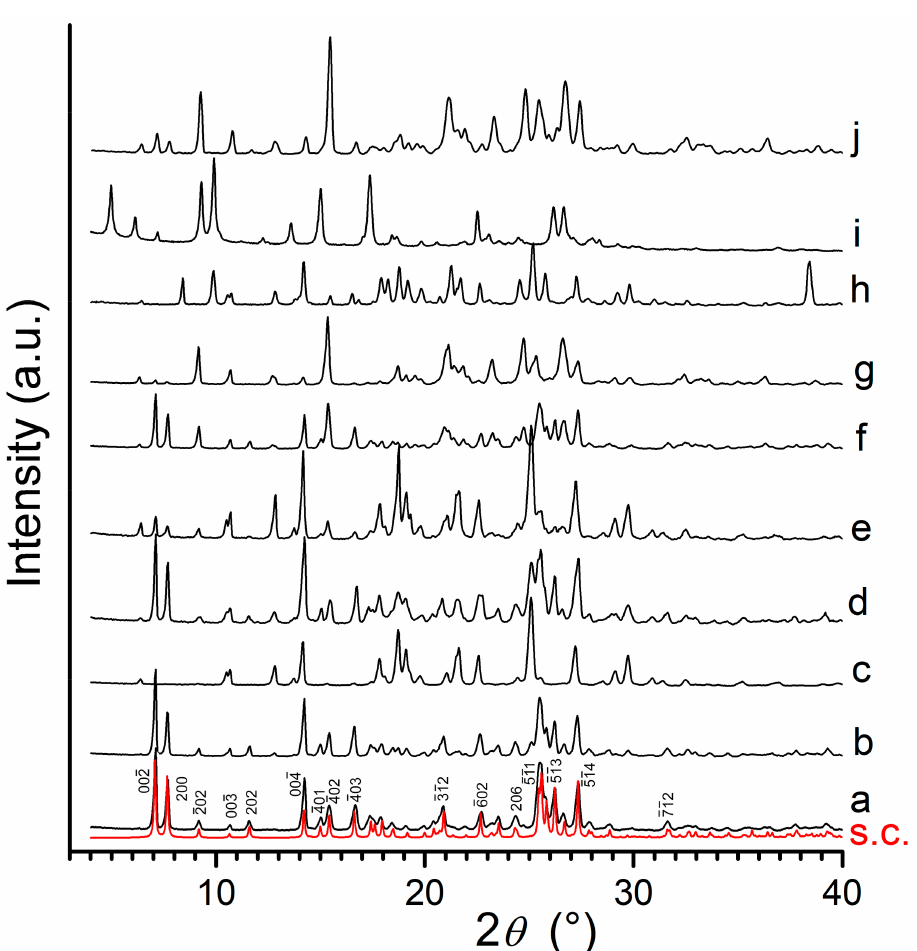
Figure 1. XRPD patterns of Tax-ET ( a ); Tax-ME ( b ); Tax-EA ( c ); Tax-AC ( d ); Tax-CH-ME ( e ); Tax-DM- ET ( f ); Tax-ACN ( g ); Tax-AET ( h ); Tax-AACN ( i ); Pristine-Tax ( j ). The pattern of Phase 1 calculated from single crystal structure [34] is also reported for comparison (red line,